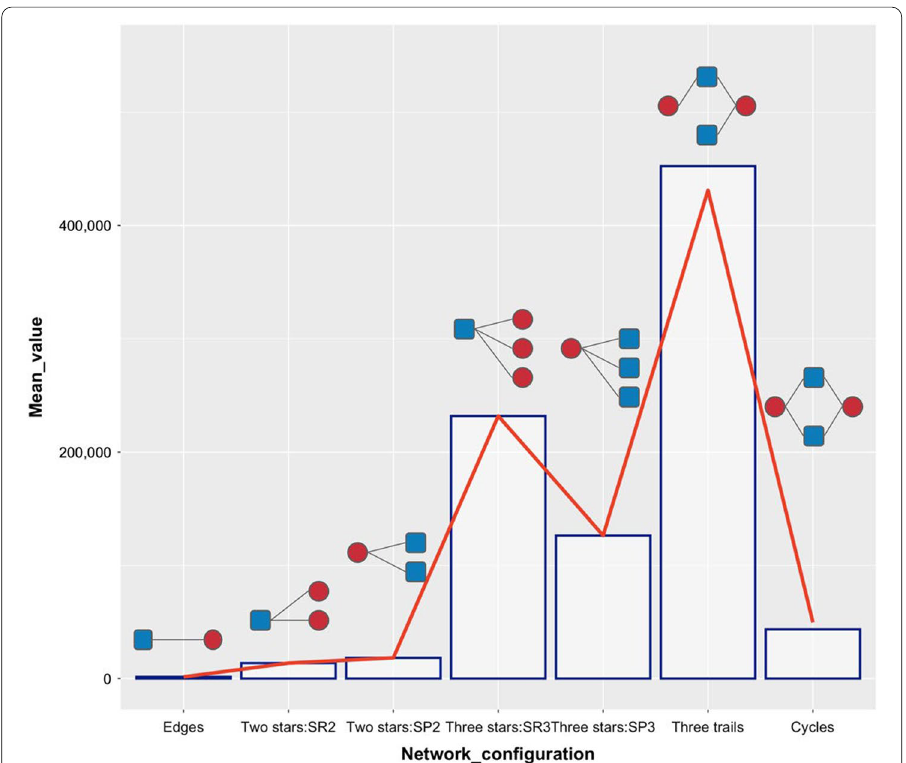
Fig. 4 Network configurations in the observed network and null models: bars show the mean value of configurations in generated null model; the line chart shows the counts of configurations in the observed network